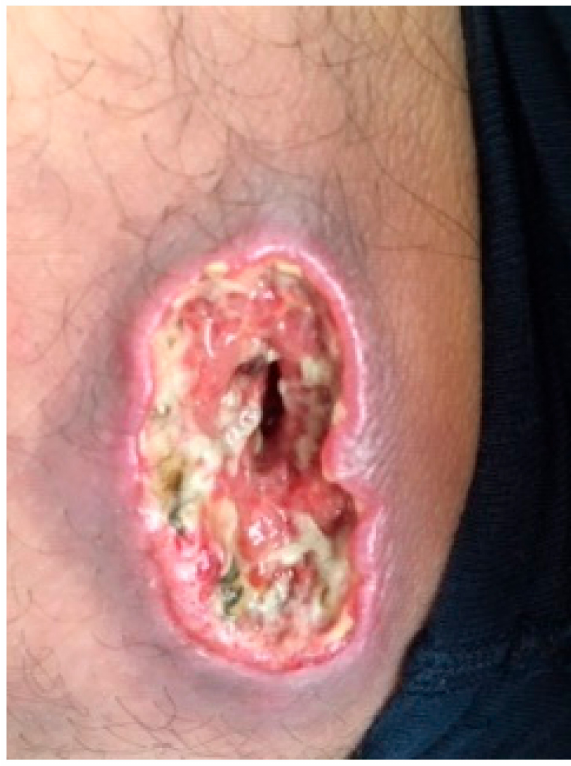
Figure 3. ALK- pcALCL single localization on a